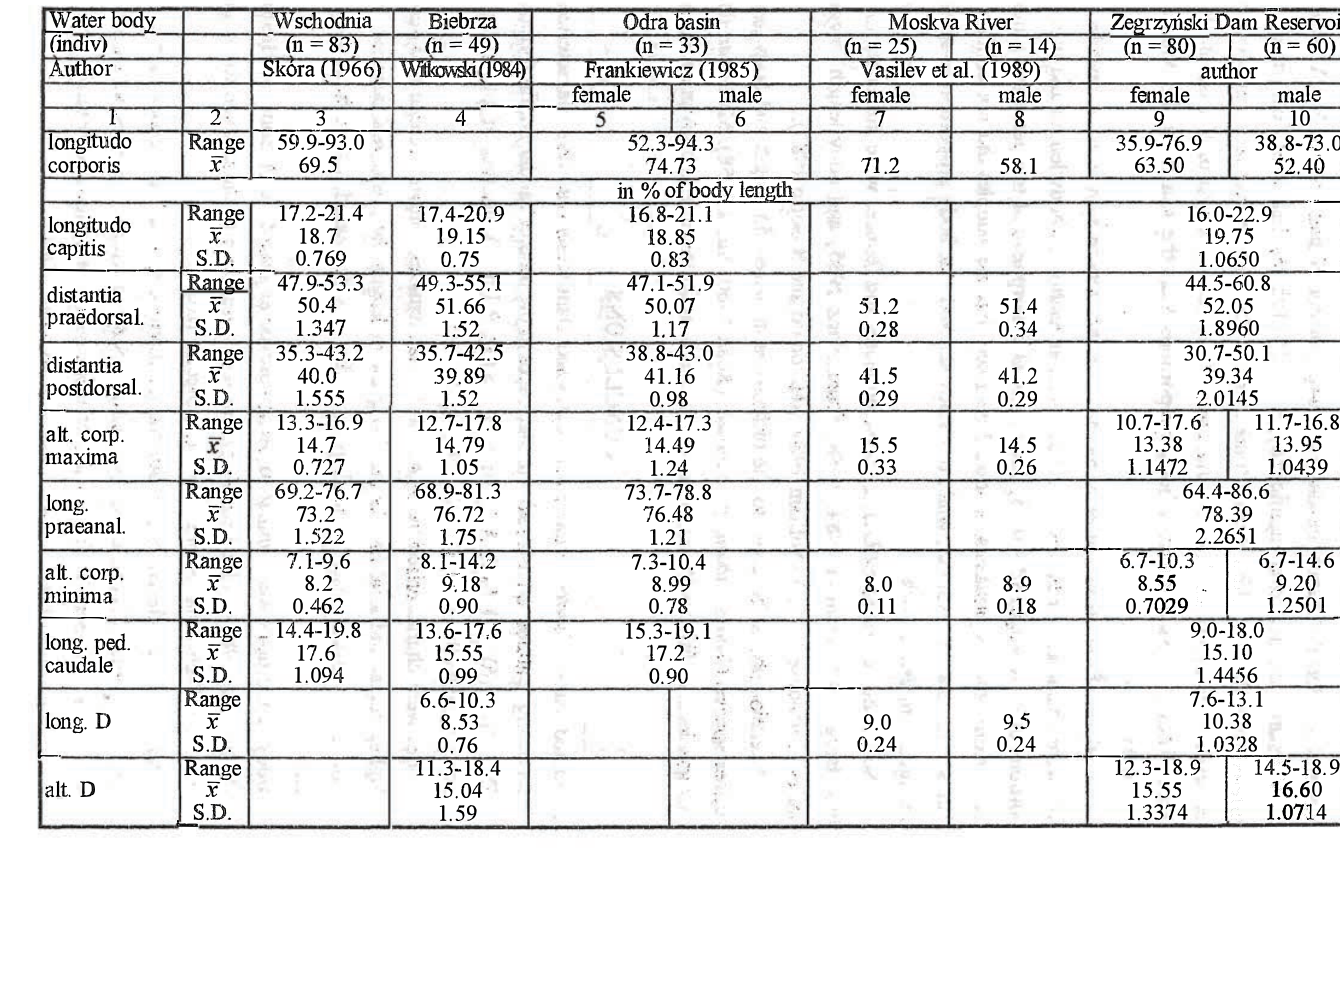
Comparison of biometric parameters of Cobitis taenia from Zegrzynski Dam Reservoir with the data from the literature Water body _Wschodnia